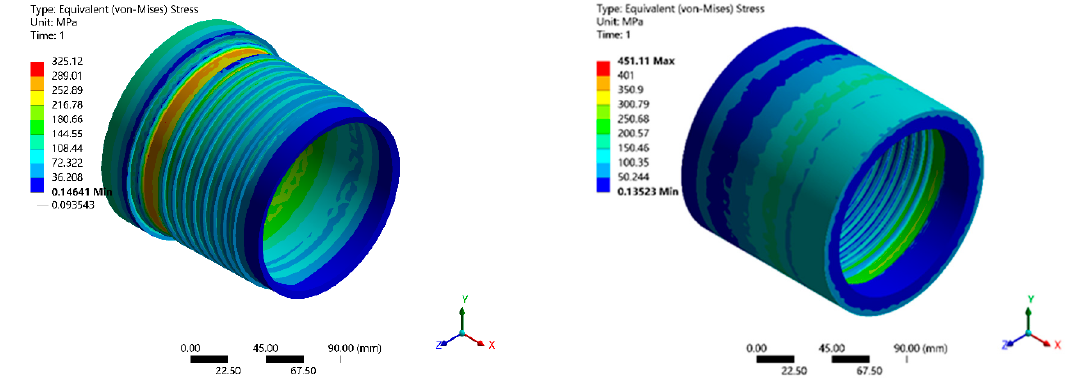
Figure 9. Stress distributions in the ( a ) pin joint and ( b ) box joint.